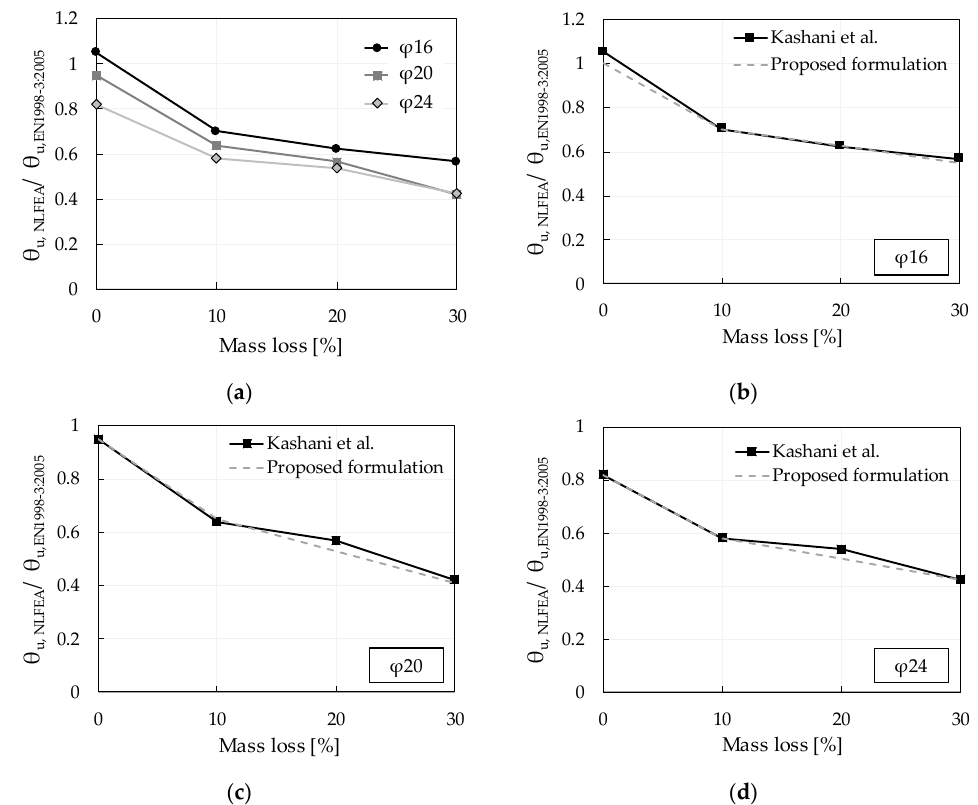
Figure 10. Normalized chord rotation in the function of the mass loss: ( a ) for different longitudinal reinforcement diameters. Proposed formulation for: ( b ) φ16, ( c ) φ20, and ( d ) φ24.